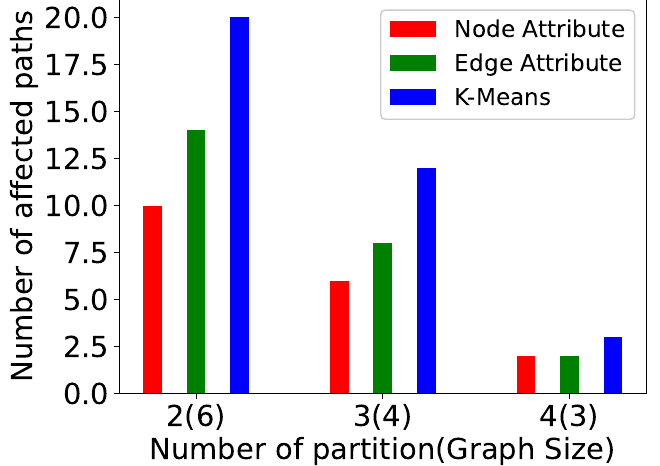
Figure 17. Paths computed in Pg-TSP for a varied number of